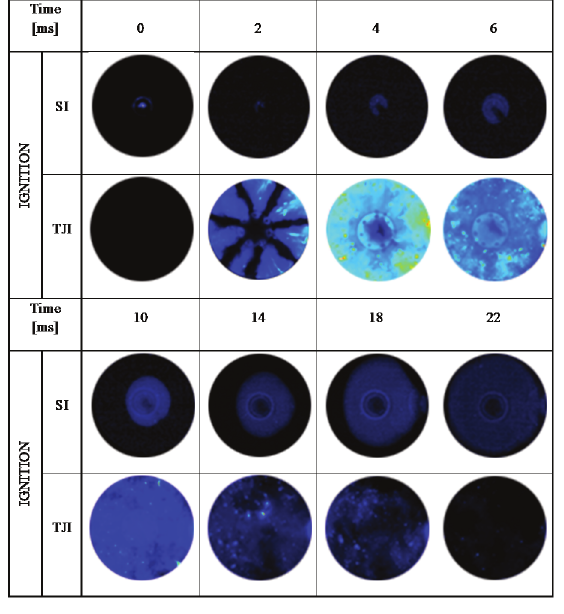
Fig. 3. Flame propagation for λ = 1.5 for SI and TJI The images (Fig. 3) represent the flame development over the time for SI (top) and TJI (bottom) in the optically accessible part of combustion chamber (Ø = 48 mm) at OA λ = 1.5. First pictures, marked as 0, represent the view from combustion chamber at the moment of ignition(SOI) and the spark plug discharge visible in the undivided combus- tion chamber (Fig. 3, top, 0 ms). Further pictures captured for SI indicate typical premixed flame characteristic for well homogenized mixture with tangential development from the ignition source to the auxiliary regions of combus- tion chamber. In case of combustion initiated with TJI, 2 ms after SOI the igniting jets already developed throughout the optically accessible part of combustion chamber. This, and also conical shape of captured jets expositions with expanded jets tips (generated from cylindrical nozzles) suggests signi- ficant contribution of jets interaction with walls of combus- tion chamber in the flame development. Next time steps indicate bigger flame luminescence in the auxiliary parts of combustion chamber, while the combustion intensity is get- ting significantly lower, from the time of 4 ms after